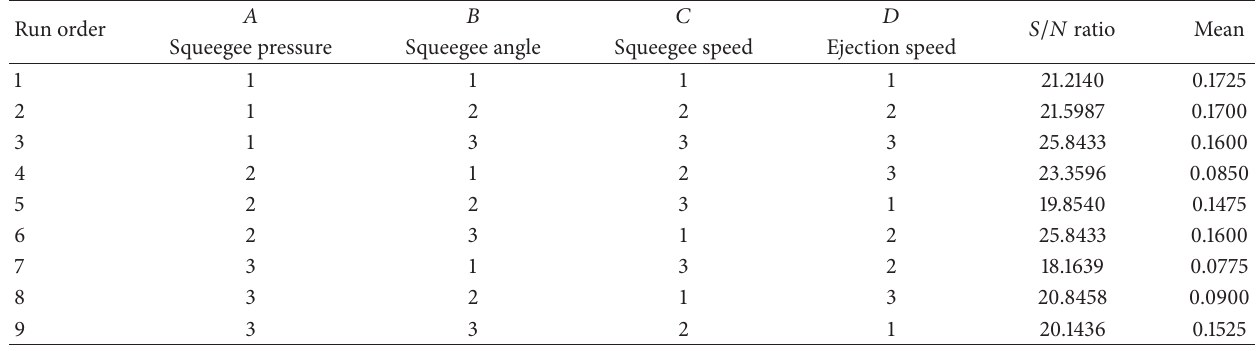
(3 4 ) orthogonal array and results. 9